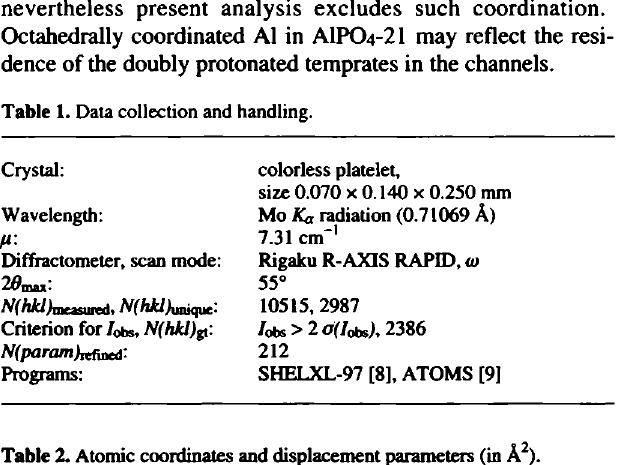
Table 2. Atomic coordinates and displacement parameters (in Ä 2 ).